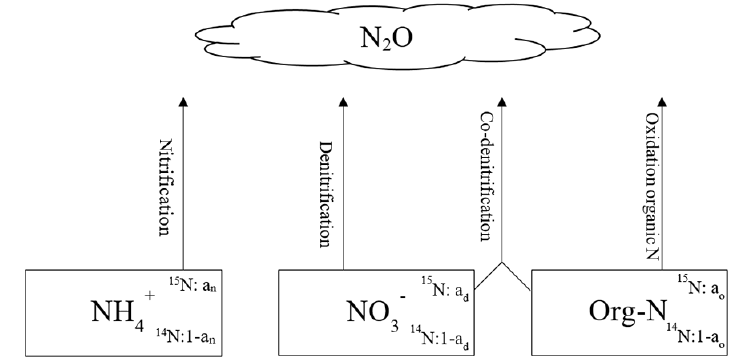
Figure 1. N 2 O production via four processes (nitrification, denitrification, co-denitrification and oxidation of organic N). Three uniformly distributed pools were considered. These pools were ammonium (NH + fraction of a d and organic N with a 15 N atom fraction of a o ( = 0.003663). The N 2 O produced via co-denitrification consists of one N atom from the nitrate pool and one from the organic N